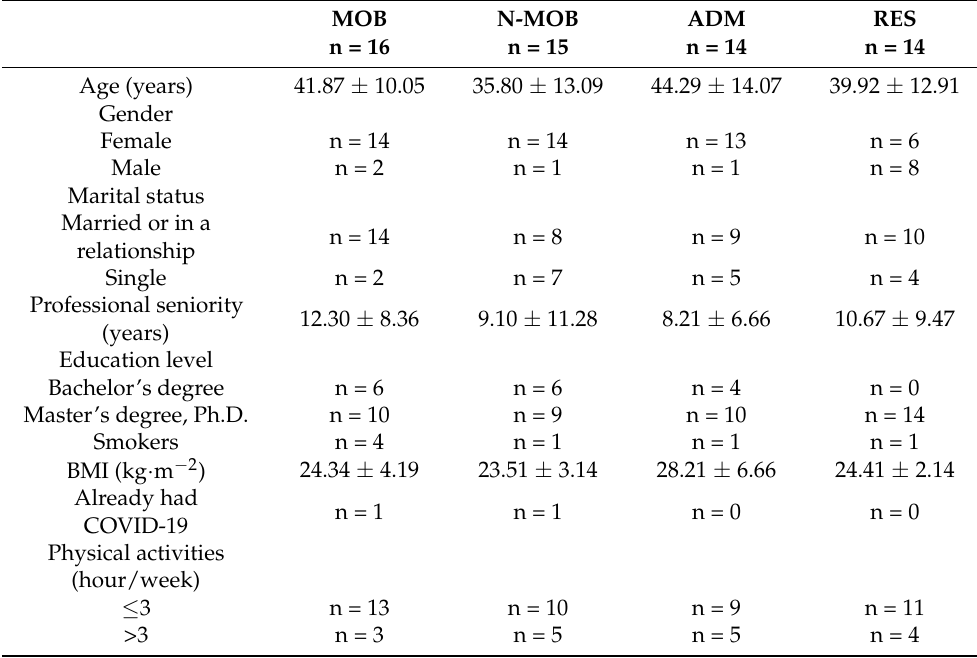
Table 1. Sociodemographic and lifestyle characteristics of the